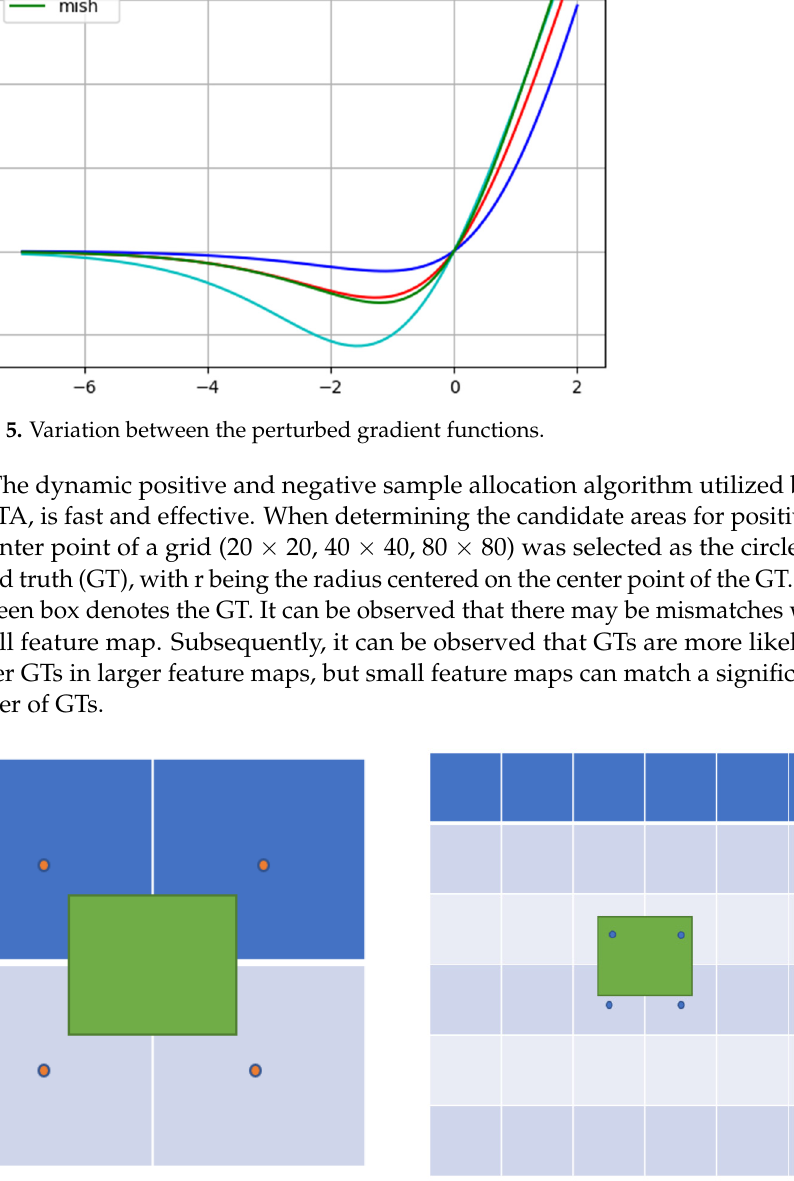
Figure 6. Feature matching candidate sample situation.